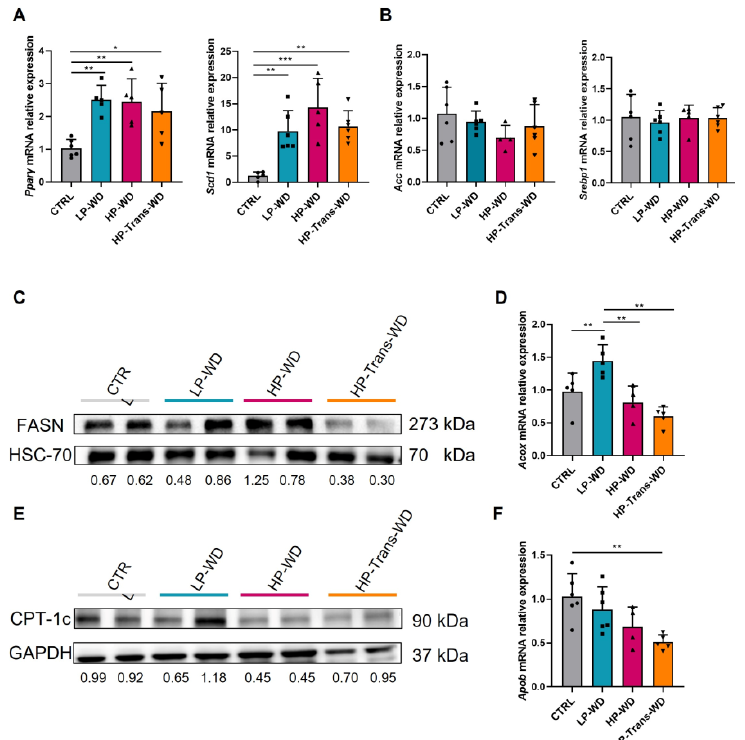
Figure 4. Changes in lipid metabolism in mice fed with WD. ( A ) Pparγ, Scd1 , ( B ) Acc, Srebp1 mRNA relative expression to GAPDH after 14 weeks on WD (n = 4–6). ( C ) FASN western blot using HSC-70 as a loading control. Ratio: normalization of FASN expression by densitometry. ( D ) Respective Acox mRNA expression relative to Gapdh (n = 4–6). ( E ) CPT-1c WB using GAPDH as loading control. Quantification of Western blot was performed by densitometry using Image J software. ( F ) Apob mRNA expression relative to Gapdh (n = 4 – 6). * for p < 0.05, ** p < 0.01, *** p < 0.001.